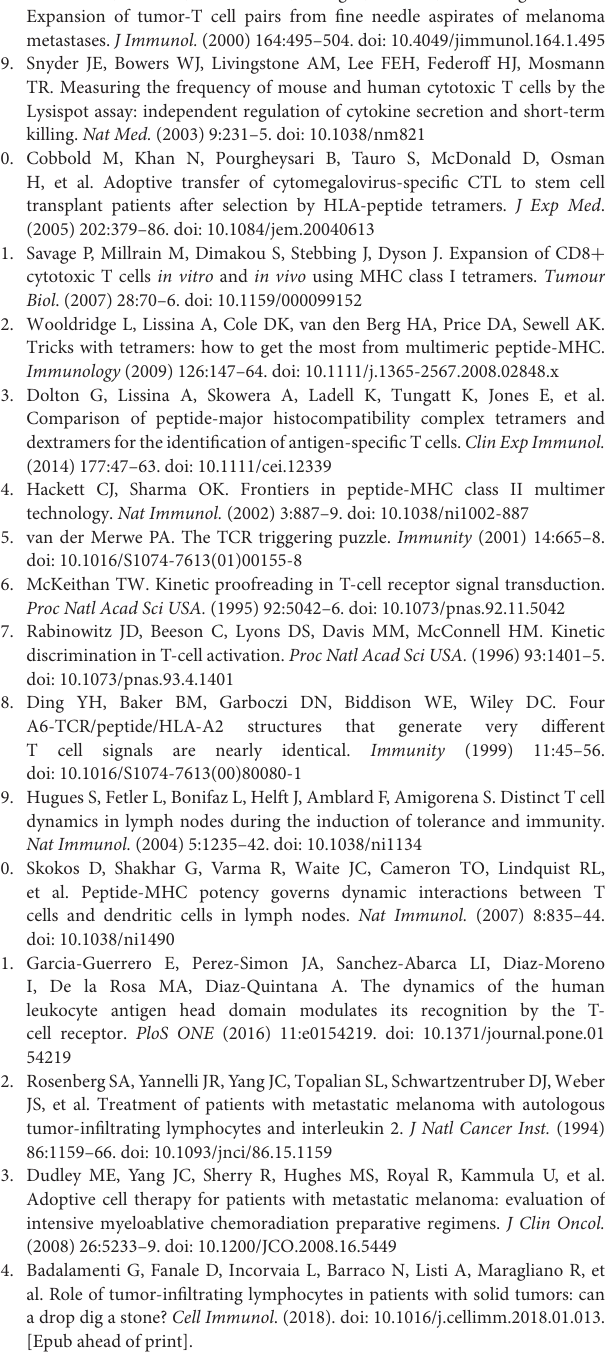
co-incubated or not with non-doublet T cells; one representative case is shown. (C) The percentage of proliferation (upper bar diagram) and CD25 expression (bottom bar diagram) of effector T cells is shown. Proliferation was assessed by PKH fluorescence using ModFit software. PKH and CD25 expression were analyzed by flow cytometry. Depicted are the mean ± SD of three independent experiments. P- values between the indicated groups were calculated using paired Student t -tests. ∗ p < 0.05 and ∗∗ p <